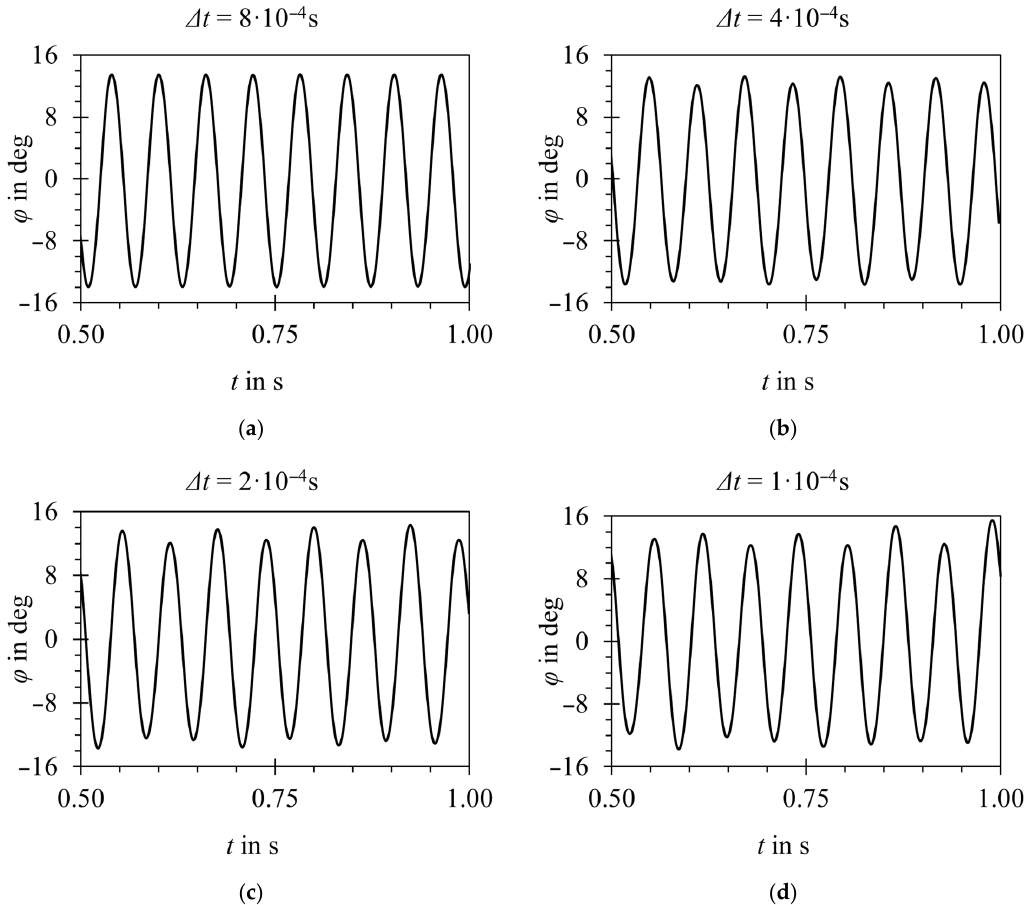
Figure 16. Oscillator position vs. time for the two-dimensional model, G3 grid, and various time-step sizes. ( a ) 8×10 − 4 s; ( b ) 4×10 − 4 s; ( c ) 2×10 − 4 s; ( d ) 1×10 − 4 s. Increased jitter with reducing time step is visible.